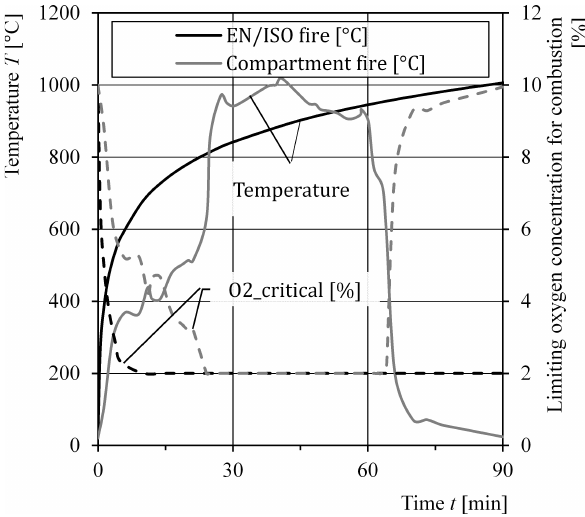
Figure 2: Application of the combustion limits (broken lines) for the EN/ISO fire and the compartment fire in Figure 1.